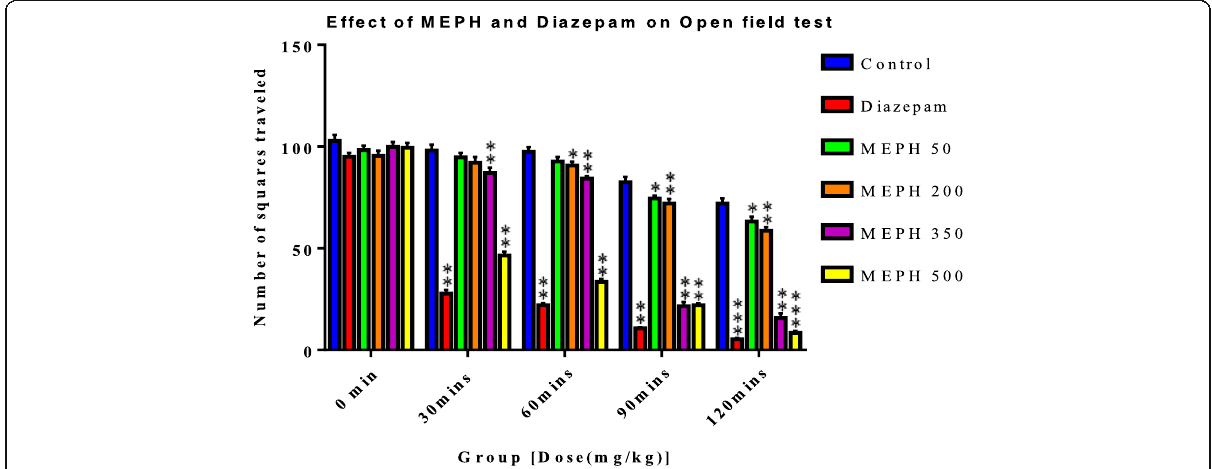
Fig. 1 The effect of MEPH on the open field test (number of square crossed at 0 min, 30 mins, 60 mins, 90 mins and 120 mins) in